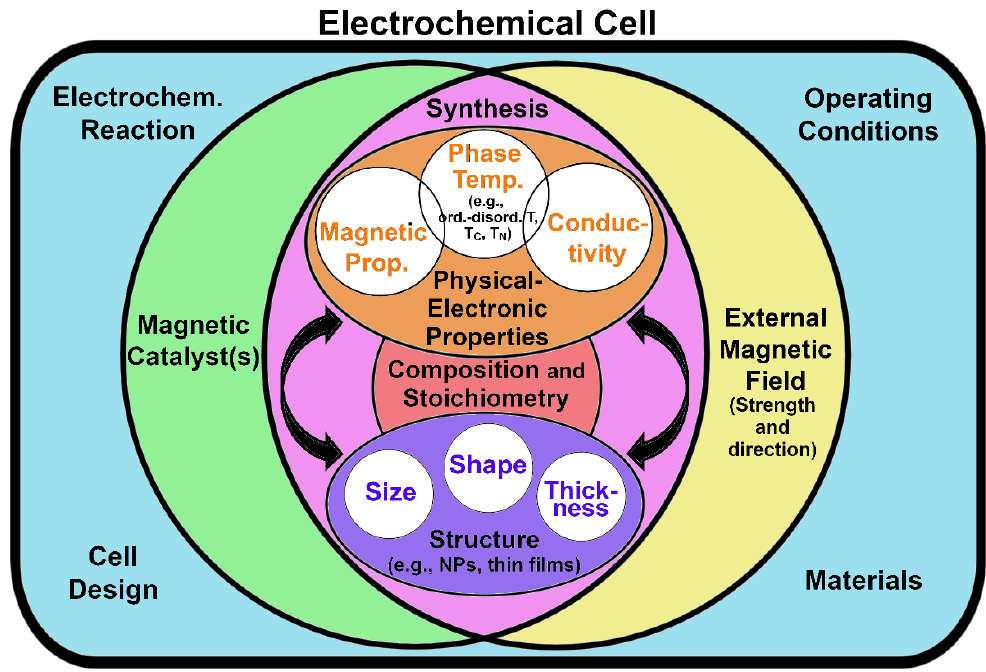
Figure 16. The most important factors and their interdependency in the magnetism-catalysis relationship for clean energy production.